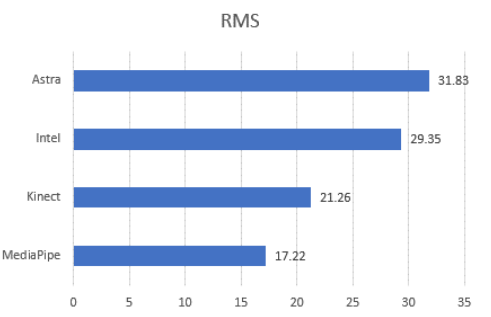
Figure 11. RMS of the absolute error for each sensor against all lower limb data in degrees.